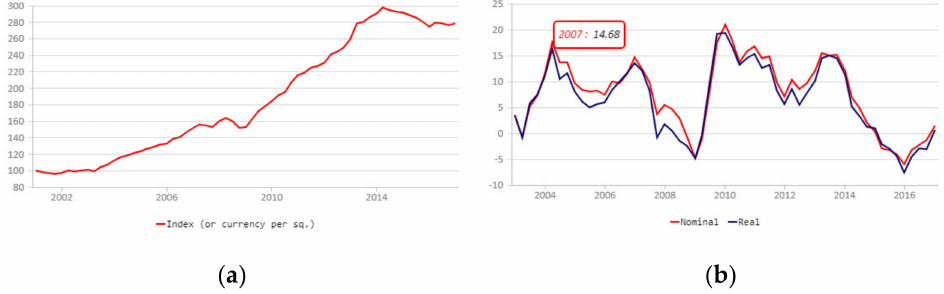
Figure 2. Lutheran home price index (Q1 2001 = 100) ( a ) and the change in house price (% change over a year earlier) ( b ) in Taipei, Taiwan